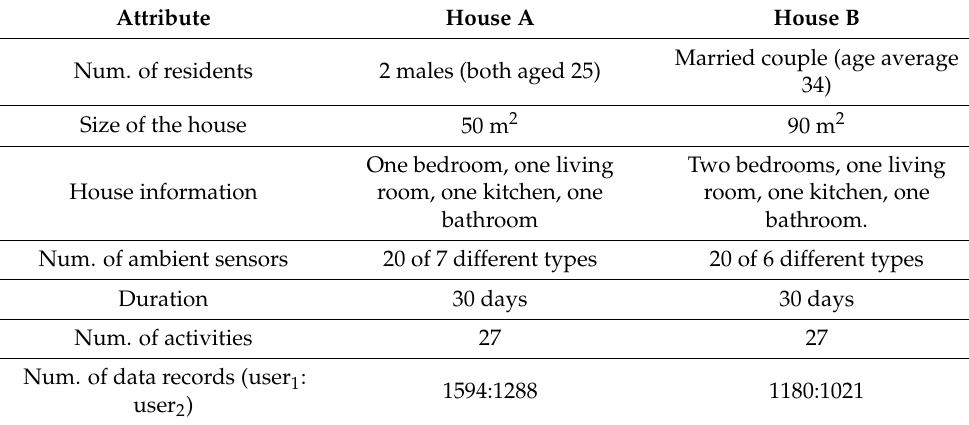
Table 5. The detailed attributes of the ARAS dataset [24].